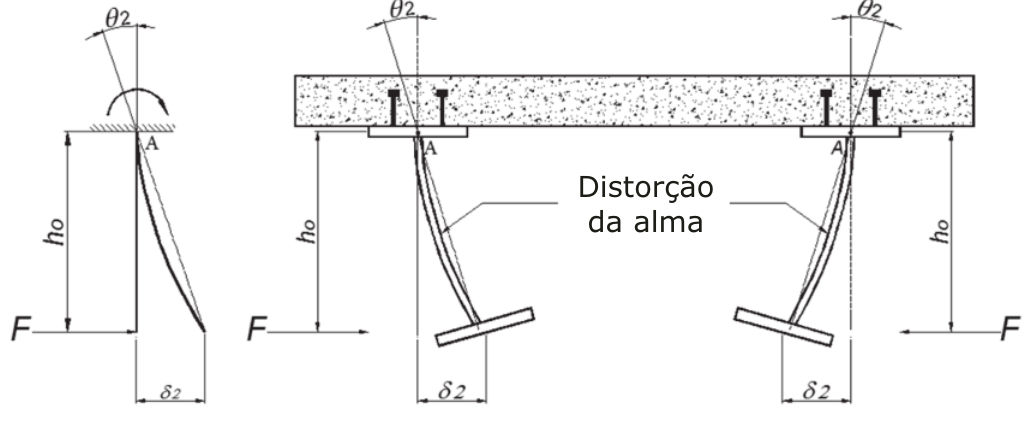
Figura 5 Rotational stiffness of the profile web [4]